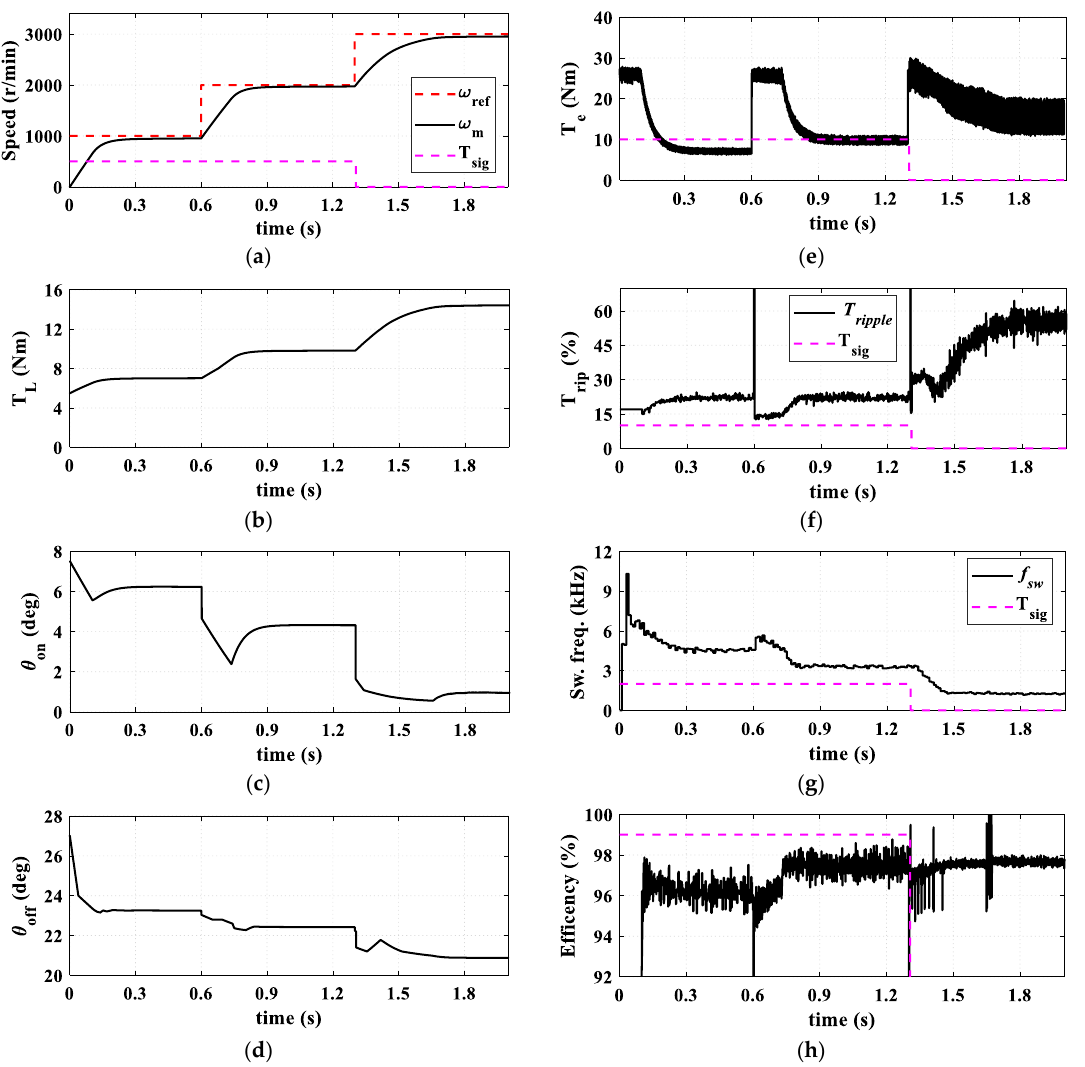
Figure 13. The simulation results under EV acceleration. ( a ) the motor speed; ( b ) the load torque on the motor side; ( c ) the variation of the turn on angle; ( d ) the variation of the turn off angle; ( e ) the total electromagnetic torque; ( f ) the torque ripple; ( g ) the switching frequency; ( h ) the effi- ciency.